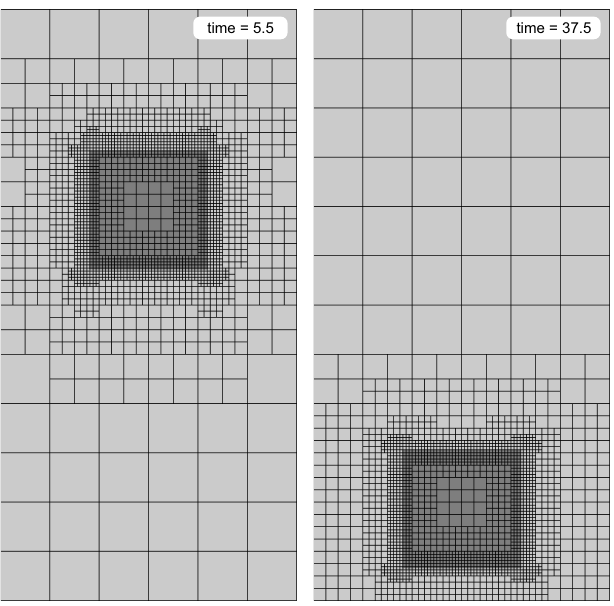
= 10 7 . Material field with η m